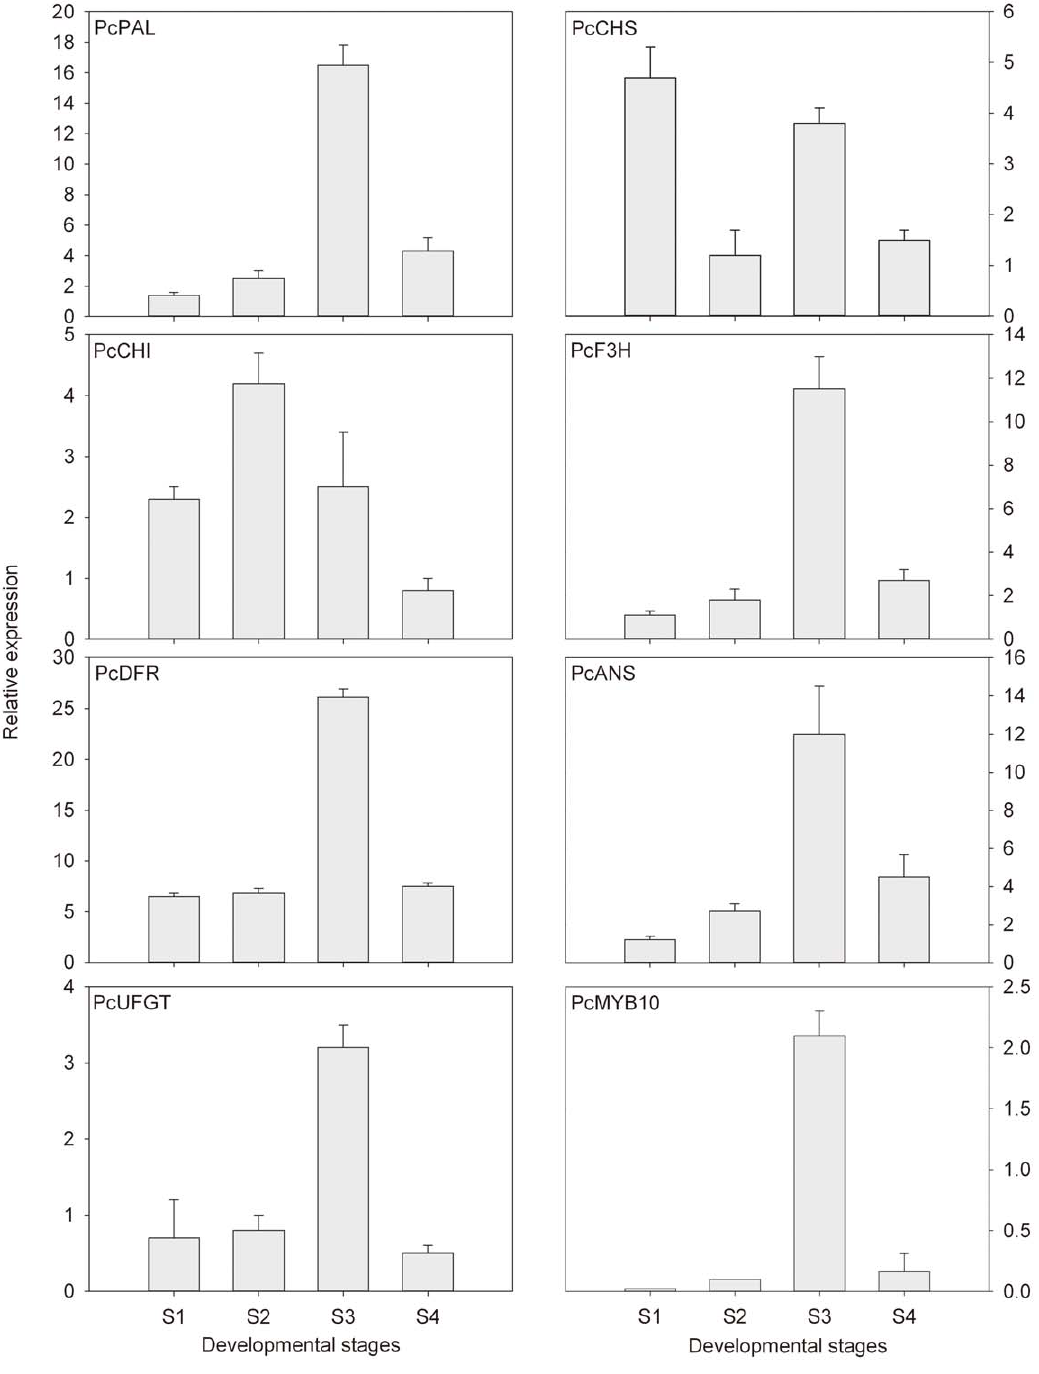
Figure 2. Expression profile of anthocyanin biosynthetic genes during pear ripening. The relative expression levels of target genes were calculated with formula 2 2 DD CT . Each point represents the mean value of three independent experiments performed upon sample triplicates 6 SE, with each triplicate derived from mRNA samples independently isolated from five fruits.